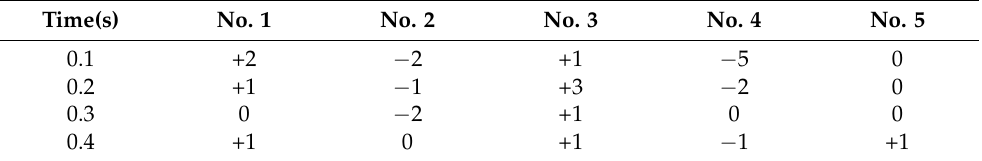
Table 3. Y-direction coordinate changes for the